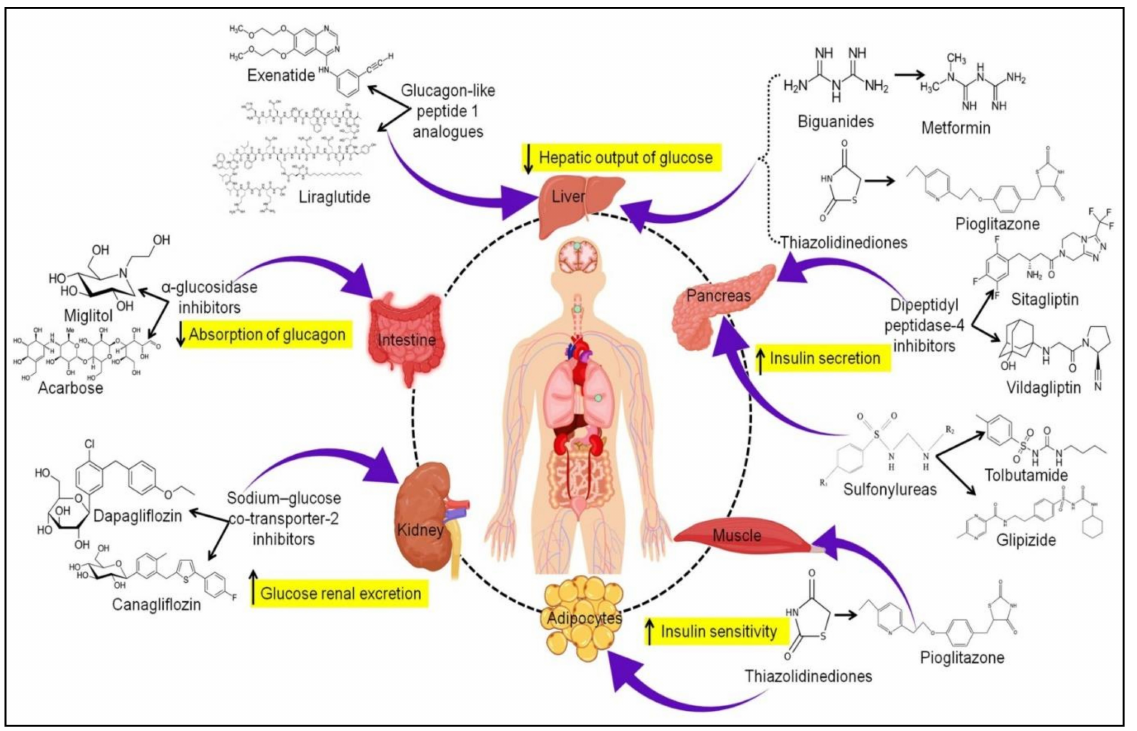
Figure 4. Pictorial representation of different categories of antidiabetic drugs and their mode of